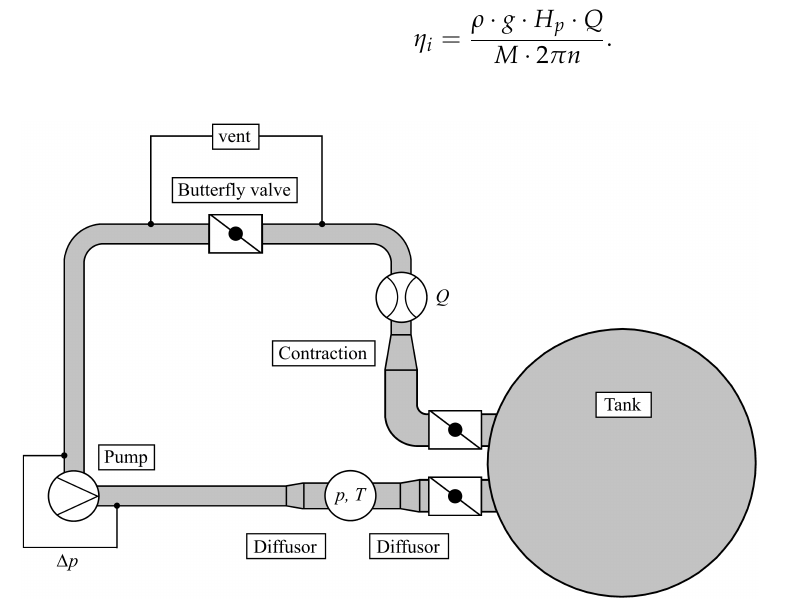
Figure 17. Schematic drawing of the test rig with the test